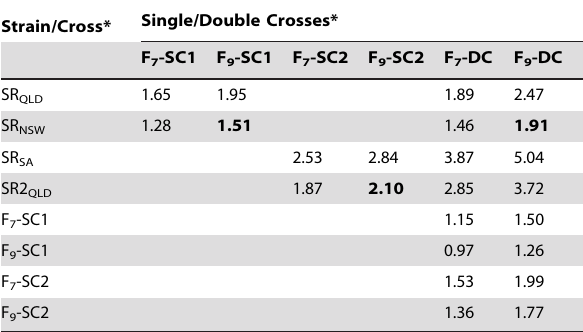
Table 3. Resistance factor of phosphine selected F 7 and F 9 progenies of both single and double crosses relative to their respective parental